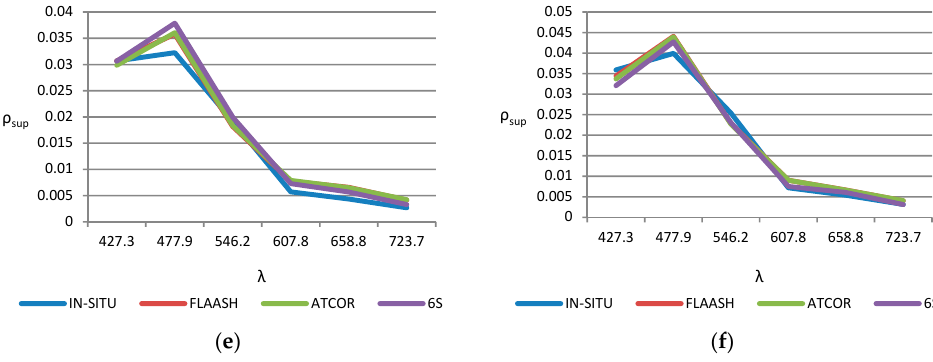
Figure 7. Spectral reflectivity signatures in the nearest coastal shallow water sites (points number 1 from A to G), as shown in Figure 2: ( a ) Coast point 1; ( b ) Coast point 4; ( c ) Coast point 5; ( d ) Coast point 8; ( e ) Coast point 10 and; ( f ) Coast point 12.